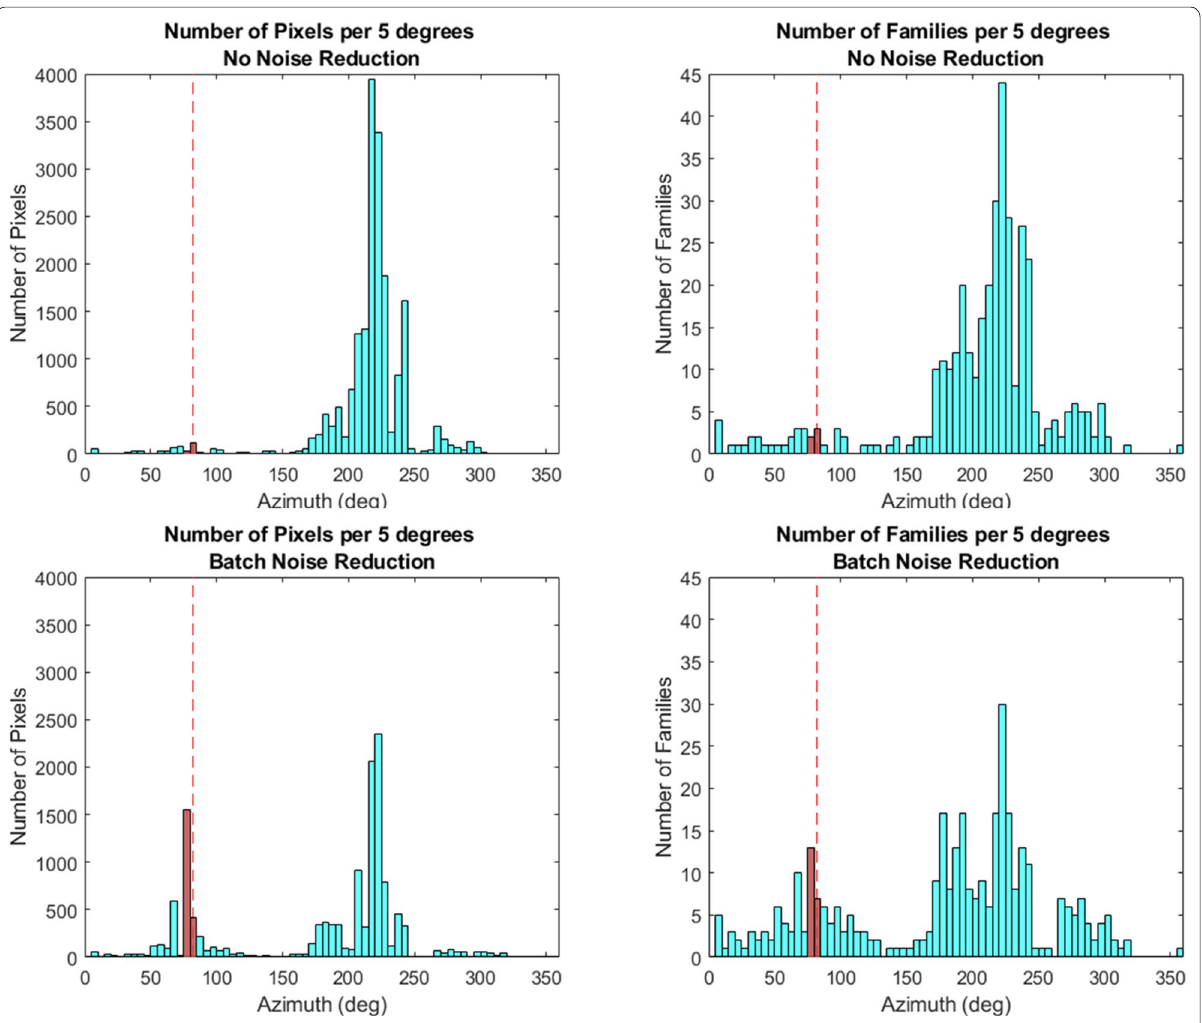
Fig. 3 Histograms of pixels and families per 5° bins from 0 to 360, back azimuth for the volcano is 82° (dashed line). In the left column are the results for number of pixels within families per 5° bin for no noise reduction (top) and a batch noise reduction by station (bottom), and the bins highlighted in red are around the known back azimuth (75°–85°). In the right column are the number of families for both no noise reduction (top) and batch noise reduction (bottom), again the bins around the known back azimuth are highlighted in